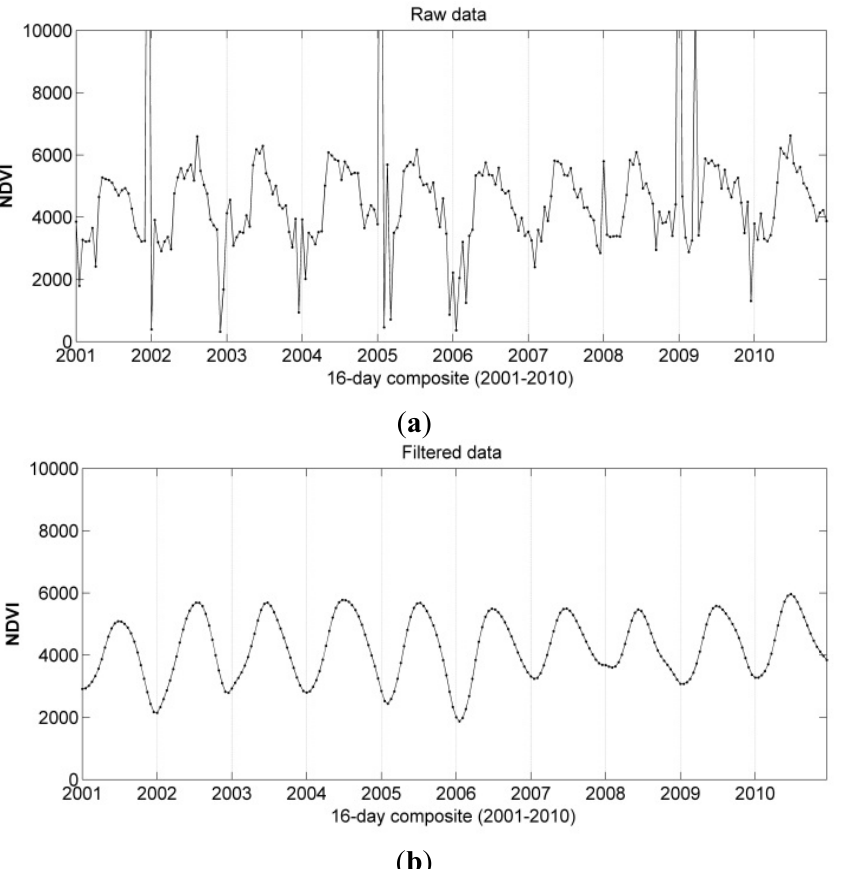
Figure 2. Example of NDVI time series before ( a ) and after ( b ) filtering. Data smoothing was achieved continuously from year 2000 to 2011 using the Whittaker smoother ( λ = 15). For the classification only data from 2001 to the end of 2010 was used and is shown in the